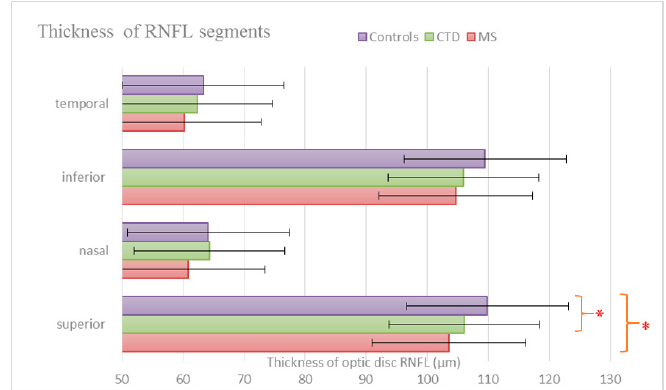
Figure 1. Mean values of optical coherence tomography (OCT) measurements of optic disc retinal nerve fiber layer (RNFL) thickness according to segments. There was a significant group effect with regard to